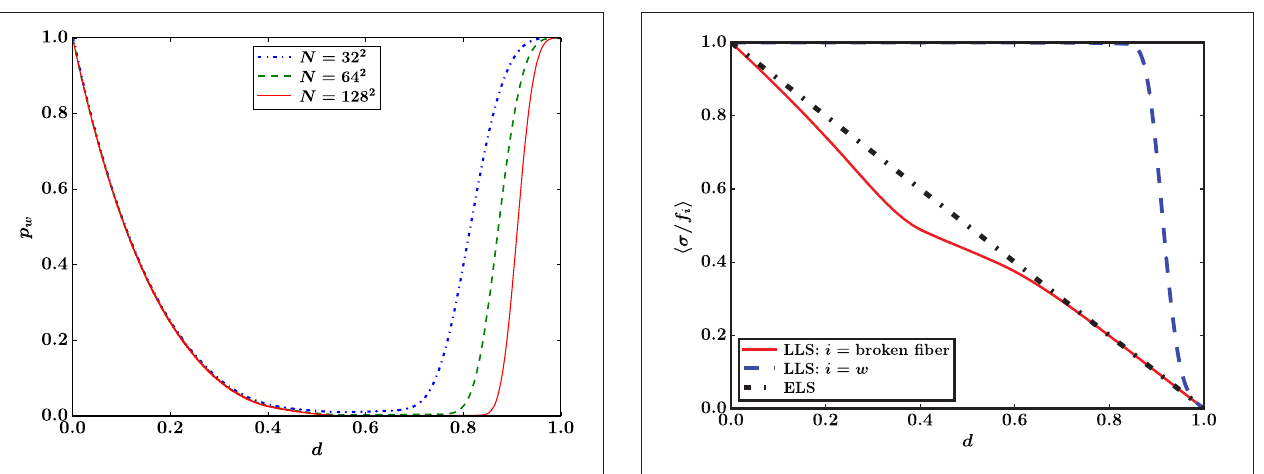
FIGURE 2 | Probability p w to break the intact fiber with the smallest threshold in LLS simulations on a square lattice. The threshold distribution is uniform: P ( t ) = t . The number of samples is 8 × 10 5 , 2 × 10 5 , and 10 5 for system sizes N = 32 2 , 64 2 , and 128 2 , respectively.